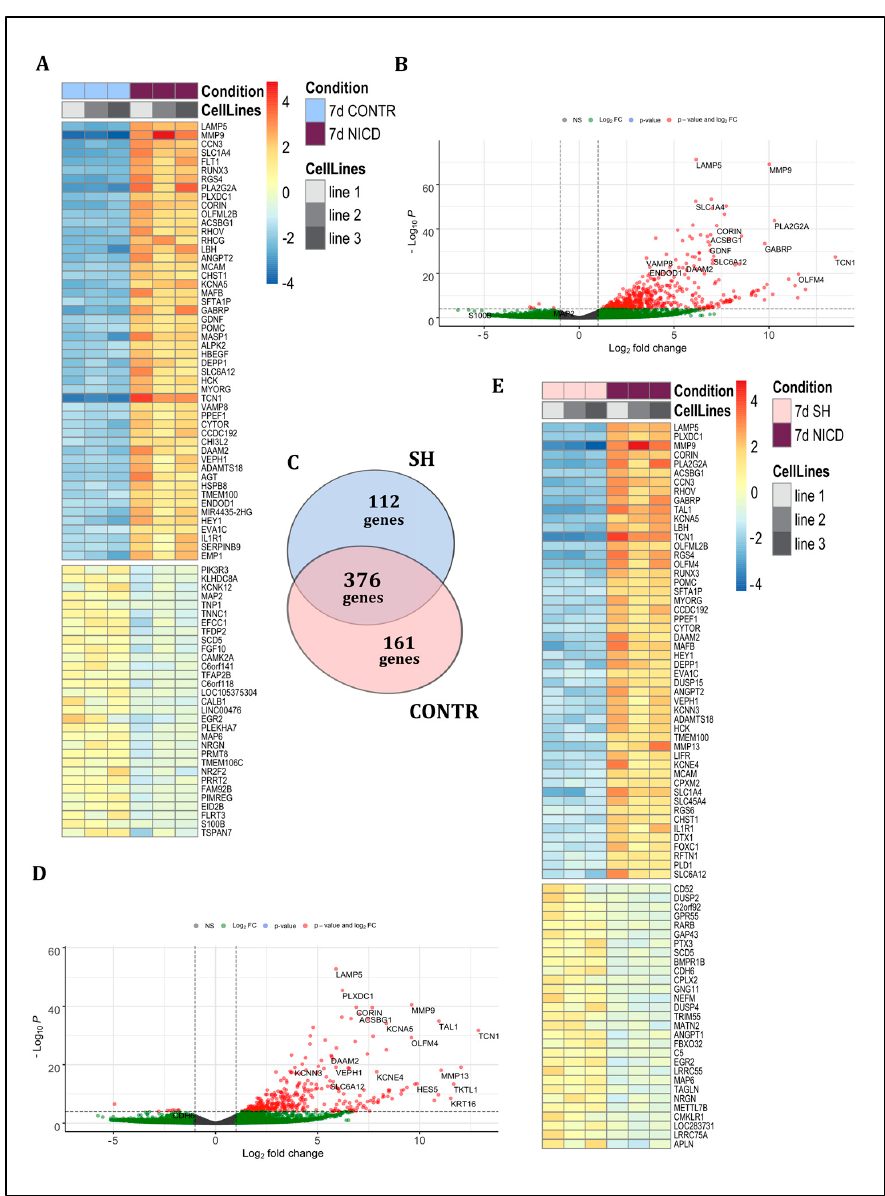
Figure 3. Comparison of transcriptomic profiles of non-treated cells (CONTR) with cells with NICD overexpression (NICD), and cells with RBPJ knockdown (SH) with NICD. ( A ) The heat map of differentially expressed genes between CONTR and NICD conditions showed an increased expression of DAAM2, ACSBG1, CORIN, GDNF, SLC6A12 genes, and a decrease of CALB1, CAMK2A, NRGN, PIK3R3, MAP2, MAP6, S100B, TSPAN7 genes in NICD conditions, top 50 genes. ( B ) volcano plot of differentially expressed genes between groups CONTR and NICD conditions; ( C ) Venn diagram of overexpressed genes in the NICD group relative to SH and CONTR groups showed the dominant overlap between these two groups; ( D ) volcano plot of differentially expressed genes between SH and NICD conditions showed an increase of expression of DAAM2, ACSBG1, VEPH1, CORIN in NICD conditions; ( E ) heat map of differentially expressed genes between SH and NICD conditions, top 50 genes.